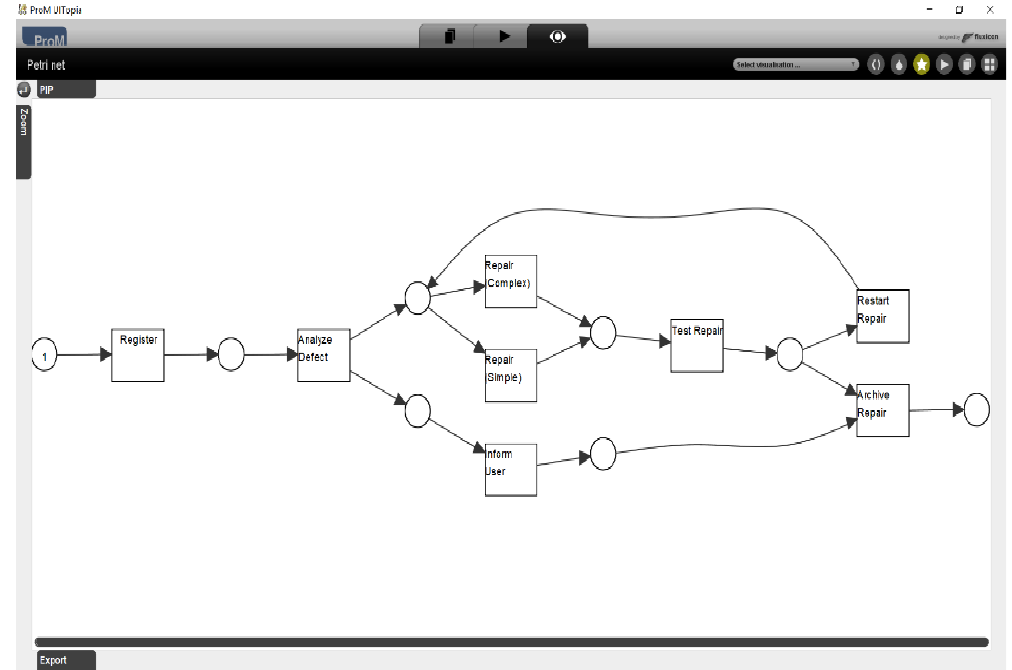
Figure 9. The business process model of the running example.